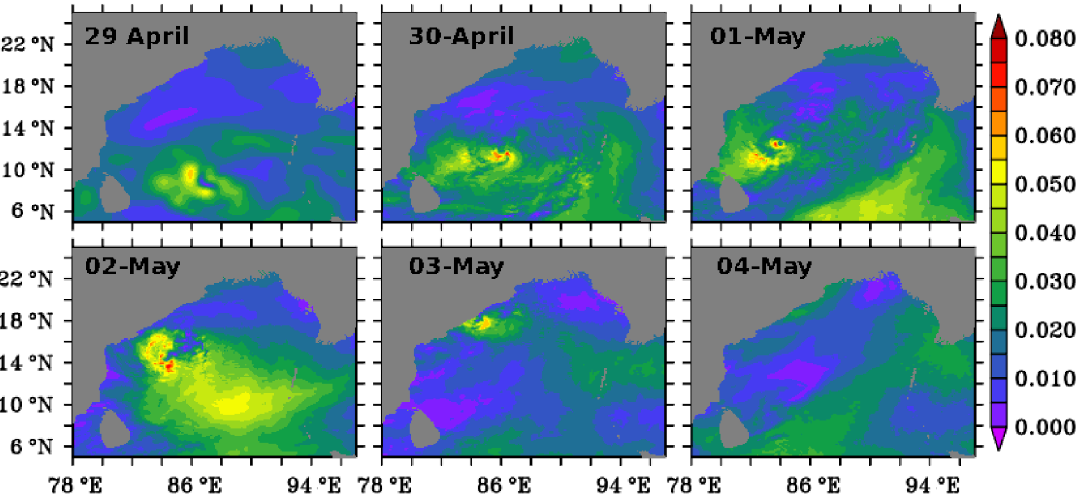
Figure 10. Model-simulated daily wind shear gradient (Nm − 2 ) (850–300 hPa) at 00 GMT each day for 29 April to 4 May 2019, during the passage of TC Fani over the BoB.